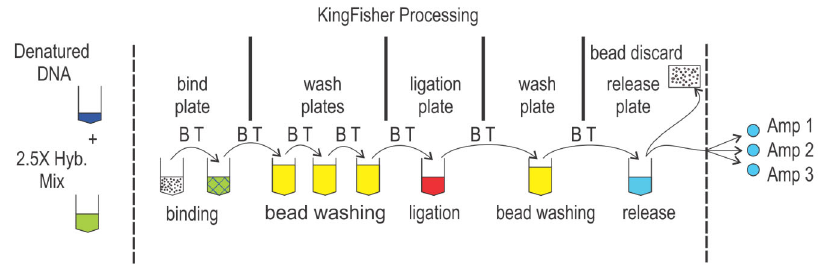
Figure 2. Sample processing sequence for a RAM assay. The figure illustrates the assay process for a single well on a KingFisher 96 well plate. The steps between the vertical dashed lines are performed as an automated sequence. Arrows indicate sequential bead transfer (BT). Beads are removed in the final step prior to RAM.